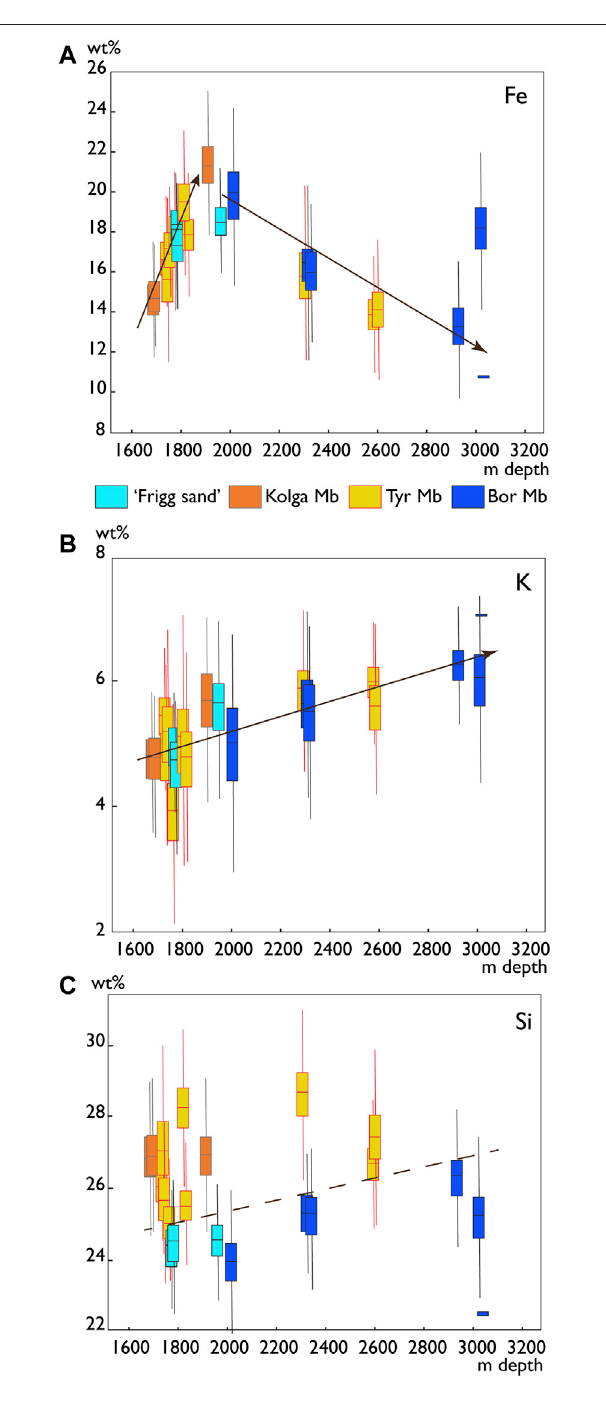
FIGURE 4 | Glauconitic clast chemistry per sample from different gravity fl ows plotted per member after their sampling depth. (A) Fe, (B) K, and (C) Si. Dashed line visualizes separation between members with low and high Si